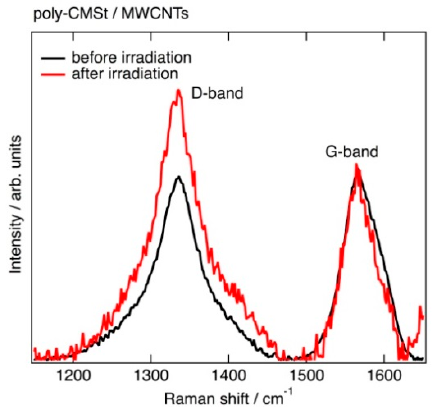
Figure 7. Raman spectra observed for poly(p-chloromethyl)styrene/multi-walled carbon nanotube mixture containing NH 2 OH···HCl, before and after ultraviolet irradiation.